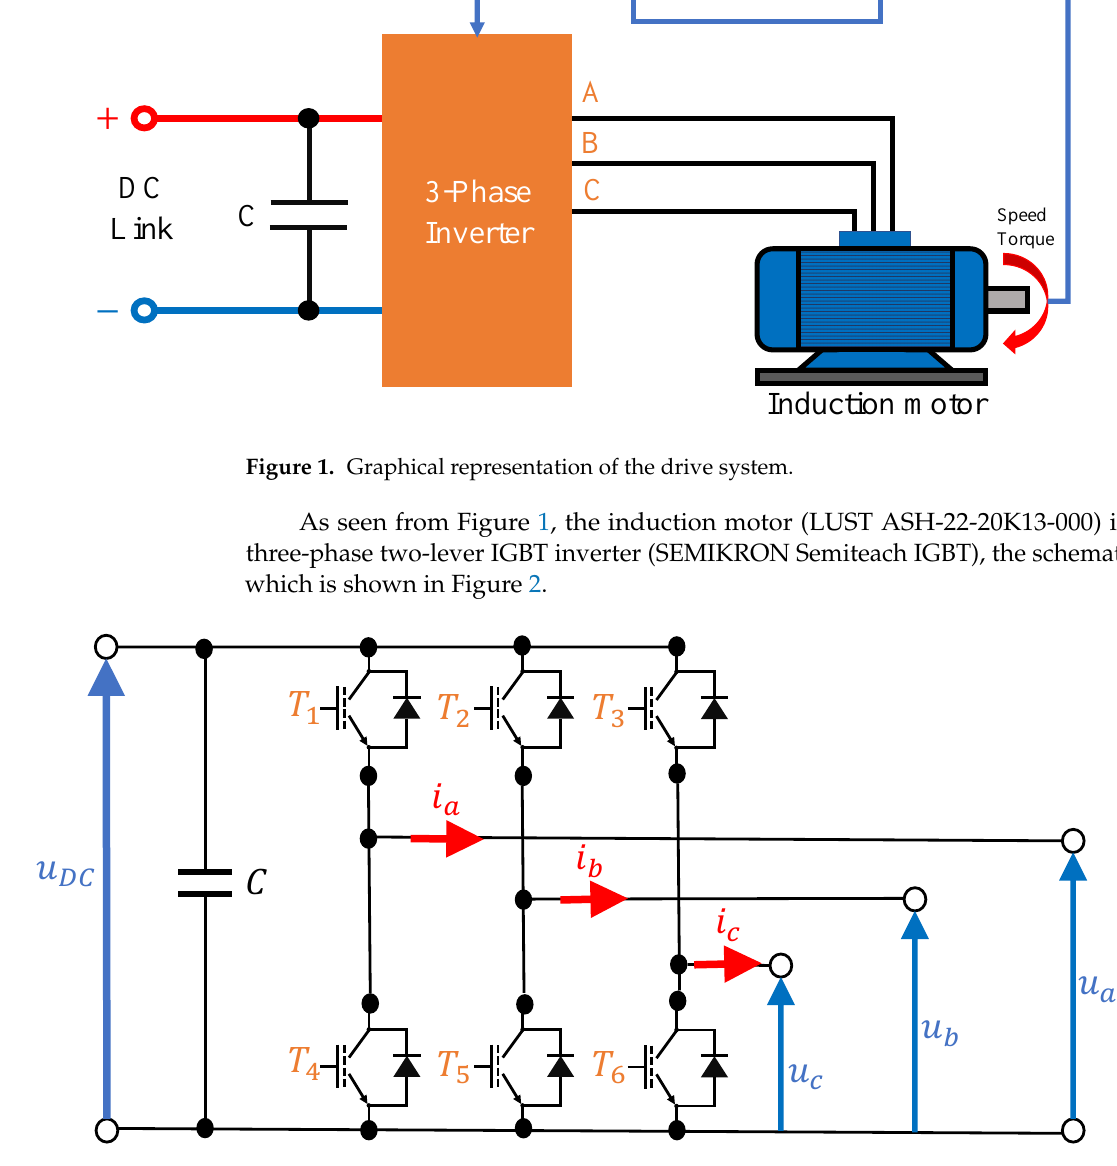
Figure 2. Schematics of the inverter in the drive system. A digital control system performs the control of the motor by the use of field-oriented control (FOC) with a switching frequency of 10 kHz. This type of system can be used for scalar and vector control of an induction motor. The induction motor control is achieved by changing the voltage and frequency of the 3-phase inverter. The change in the voltage and frequency is achieved with sinusoidal PWM. The PWM pulses are supplied to the gates of the insulated-gate bipolar transistor (IGBT) of the inverter. The measurement structure used by the authors in [37] is shown in Figure